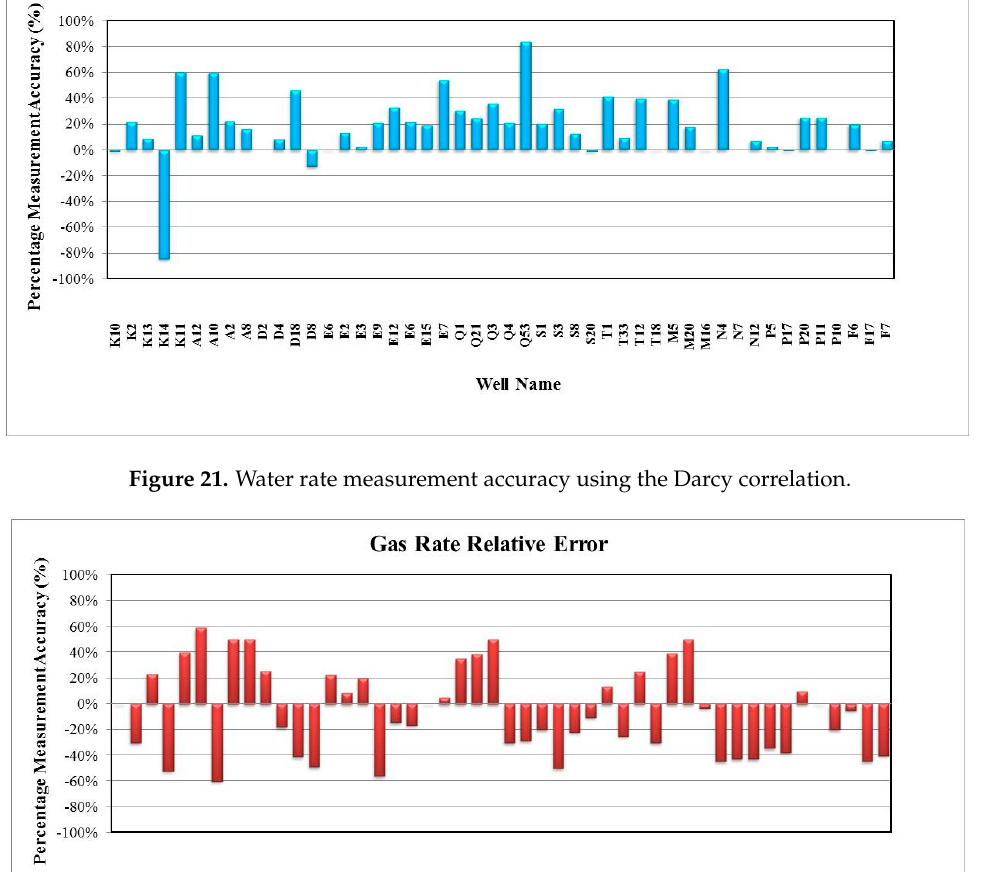
17 of 23 Figure 19. Gas rate measurement accuracy using the Blasius correlation.